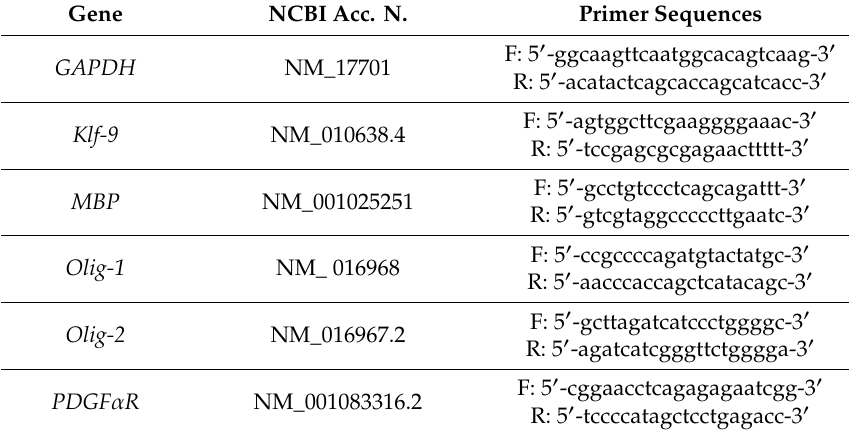
Table A1. Primers sequences. Gene NCBI Acc.